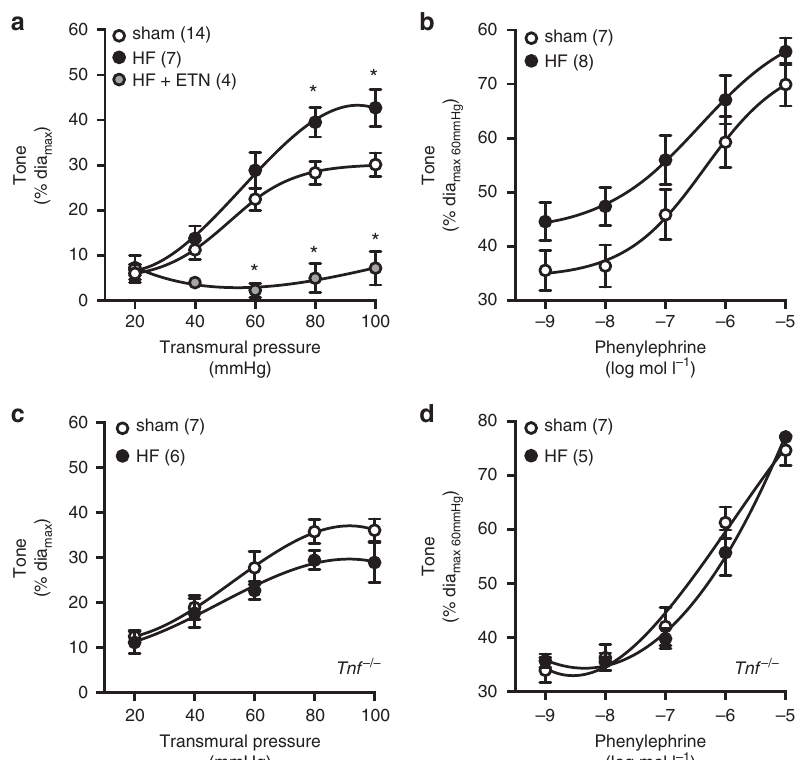
Figure 1 | Effects of TNF disruption on myogenic responsiveness and in HF. HF was induced by left anterior descending coronary artery ligation. Sham- operated mice served as controls. Pressure myography of cremaster skeletal muscle resistance arteries isolated from wild type and Tnf (cid:2) / (cid:2) mice. ( a ) Myogenic responsiveness and ( b ) phenylephrine-induced vasoconstriction was assessed in arteries from wild-type mice in the absence and presence of etanercept (ETN, 300 m gml (cid:2) 1 in vitro ). ( c ) Myogenic responsiveness and ( d ) phenylephrine-induced vasoconstriction was assessed in arteries from Tnf (cid:2) / (cid:2) mice. Numbers in parentheses indicate the number of arteries in each group. All data are mean ± s.e.m. * P o 0.05 for one-way ANOVA and Dunnett’s post hoc test relative to sham ( a ). An unpaired Student’s t- test at each pressure and drug dose was nonsignificant ( b – d ). ANOVA, analysis of variance. distension control: 10.4 ± 0.6 vs 10 m g ml (cid:2) 1 ETN: 10.4 ± 0.7, P ¼ nonsignificant in a paired Student’s t -test, n ¼ 5 arteries),